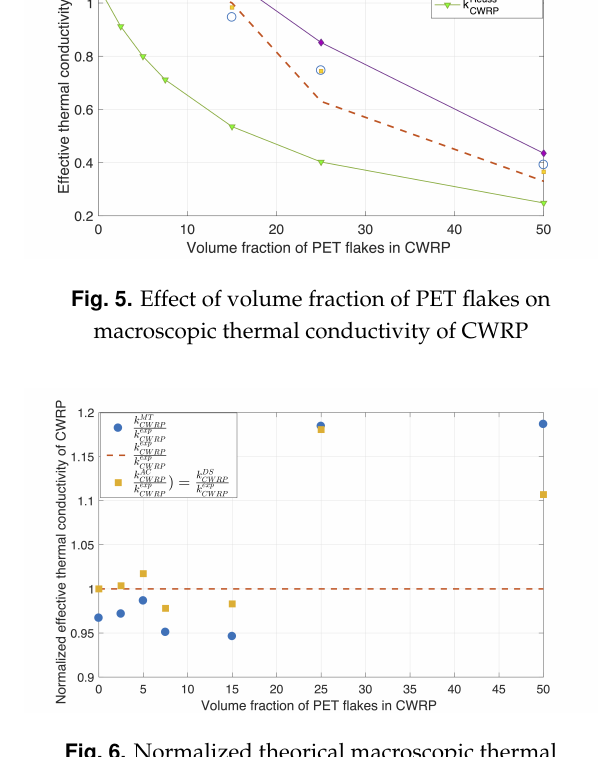
Fig. 6. Normalized theorical macroscopic thermal conductivity of CWRP via experimental